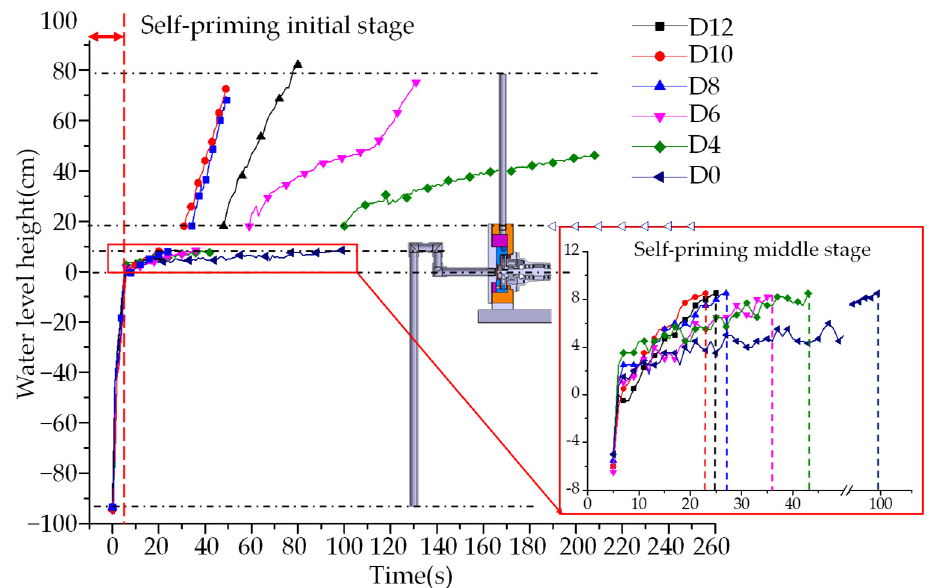
Figure 7. Water level change law with different reflux hole diameters.